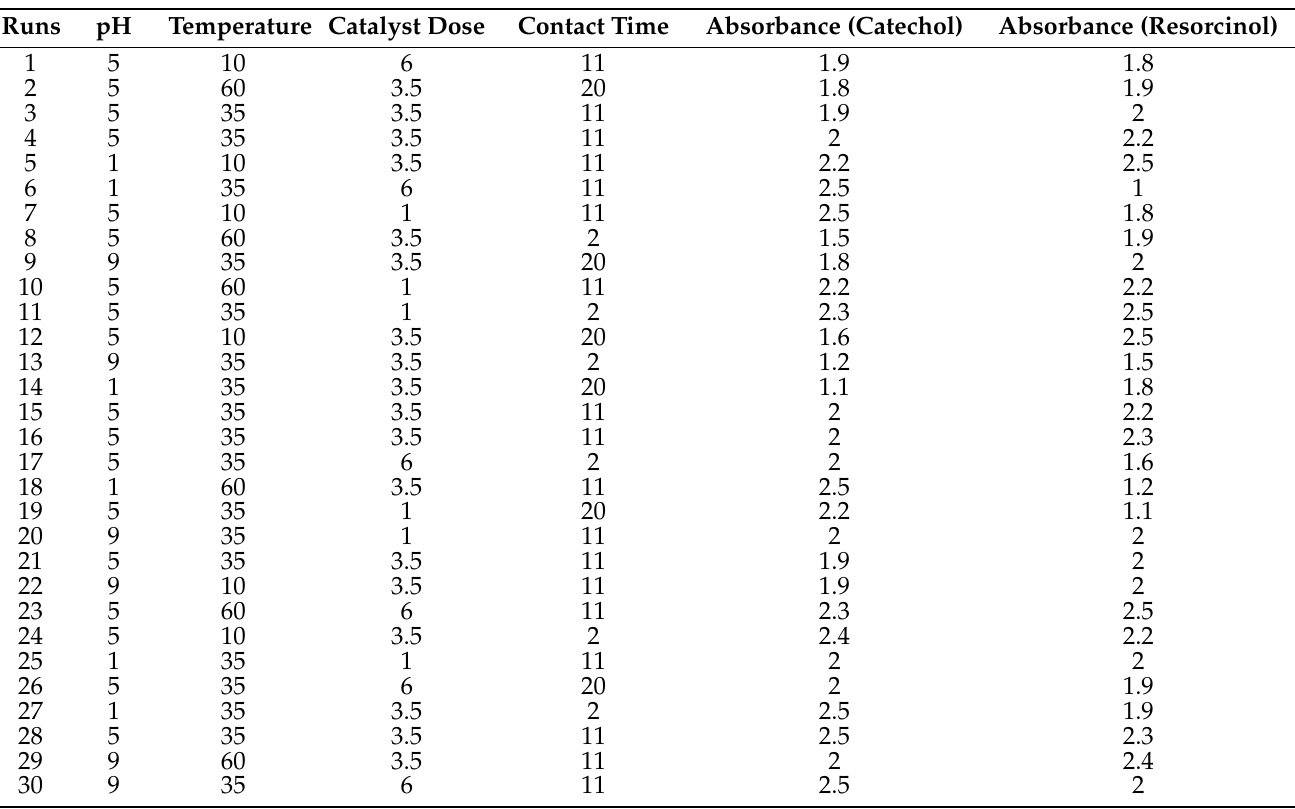
Table 4. Results of analysis of variance for the enzyme activity of nanocomposite using catechol and